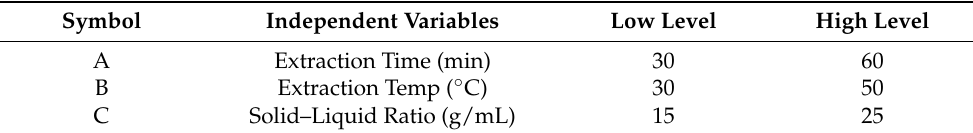
Table 1. Experimental design and levels of independent process